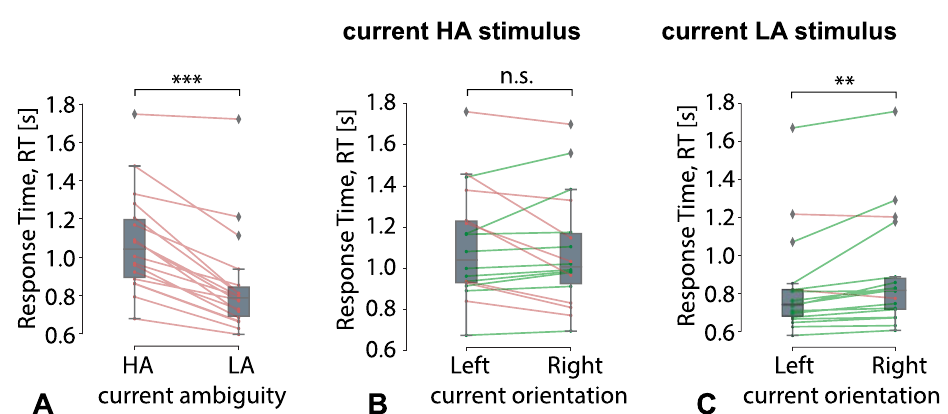
Figure 2. Effect of the current stimulus orientation and ambiguity on the RT, regardless of the previous stimulus orientation and ambiguity. Box-plot illustrates the median RT in the group of subjects for ( A ) HA and LA stimuli, p < .001 ∗∗∗ . ( B ) HA stimuli with left and right orientations, p = .3 . ( C ) LA stimuli with left and right orientation, p < .01 ∗∗